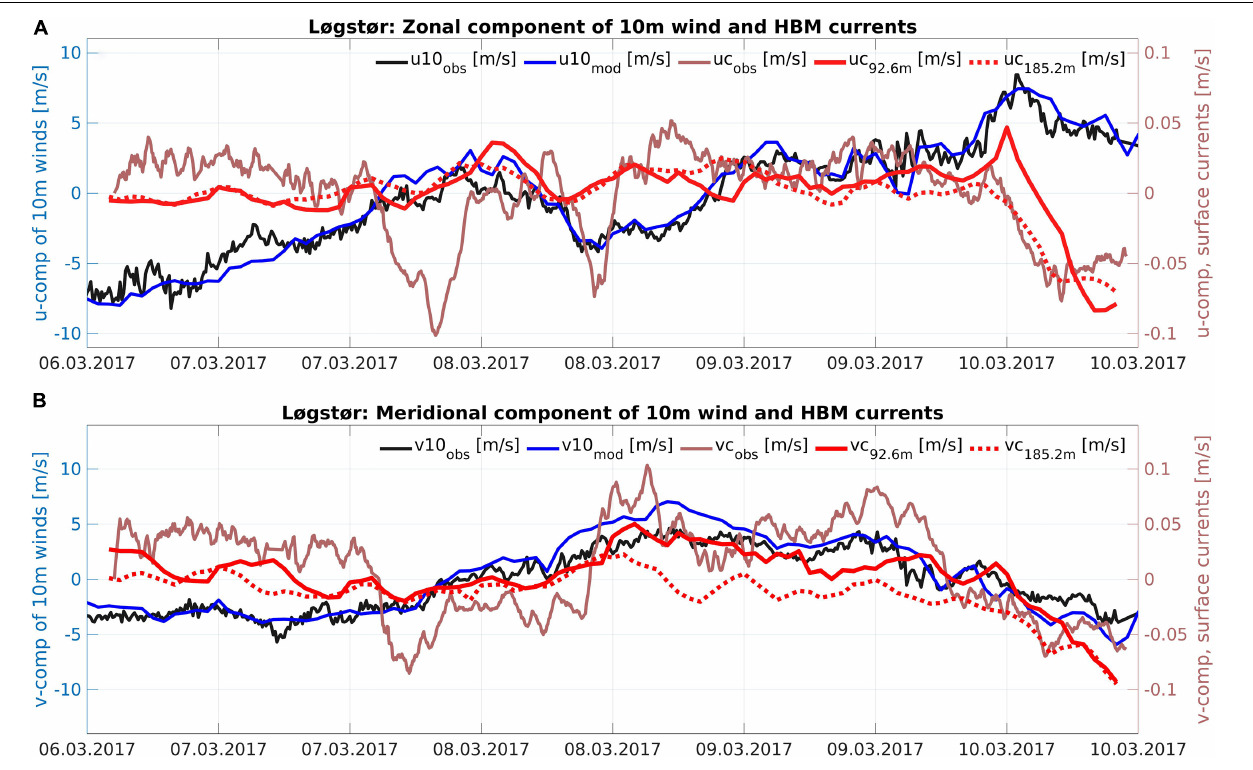
FIGURE 12 | Logstør: Zonal (A) and Meridional (B) winds at 10 m height (u10, v10) and surface currents (uc, vc). Modeled winds (blue) and observed winds (black) at Aars Syd (56 ◦ 48 (cid:48) 11.7 (cid:48)(cid:48) N, 9 ◦ 31 (cid:48) 3.9 (cid:48)(cid:48) E) and modeled surface currents (bright red) and observed currents (faint red) at Løgstør. Full, red lines: double horizontal resolution (92.6 m), dotted red lines: standard resolution (185.2